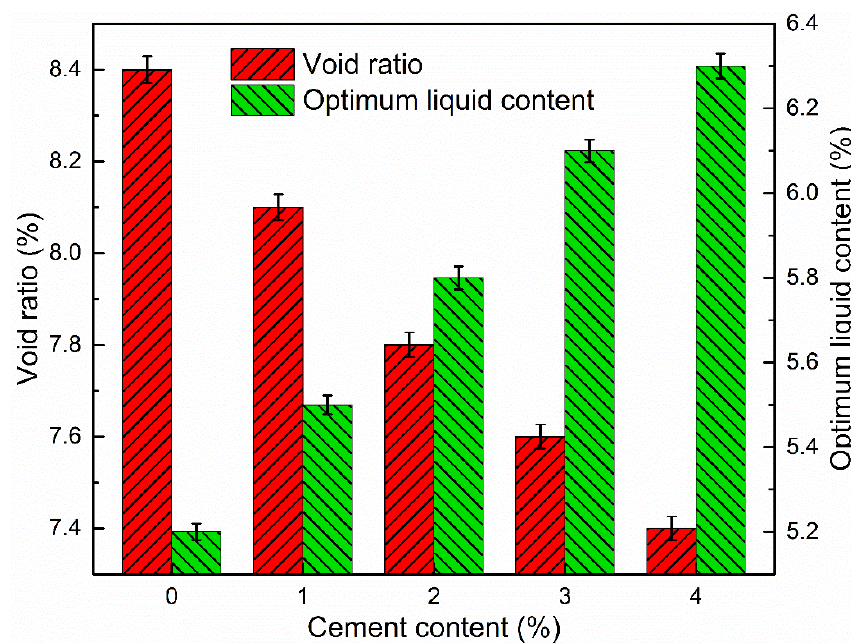
Figure 12. Influence of cement content on void ratio and optimum liquid content.